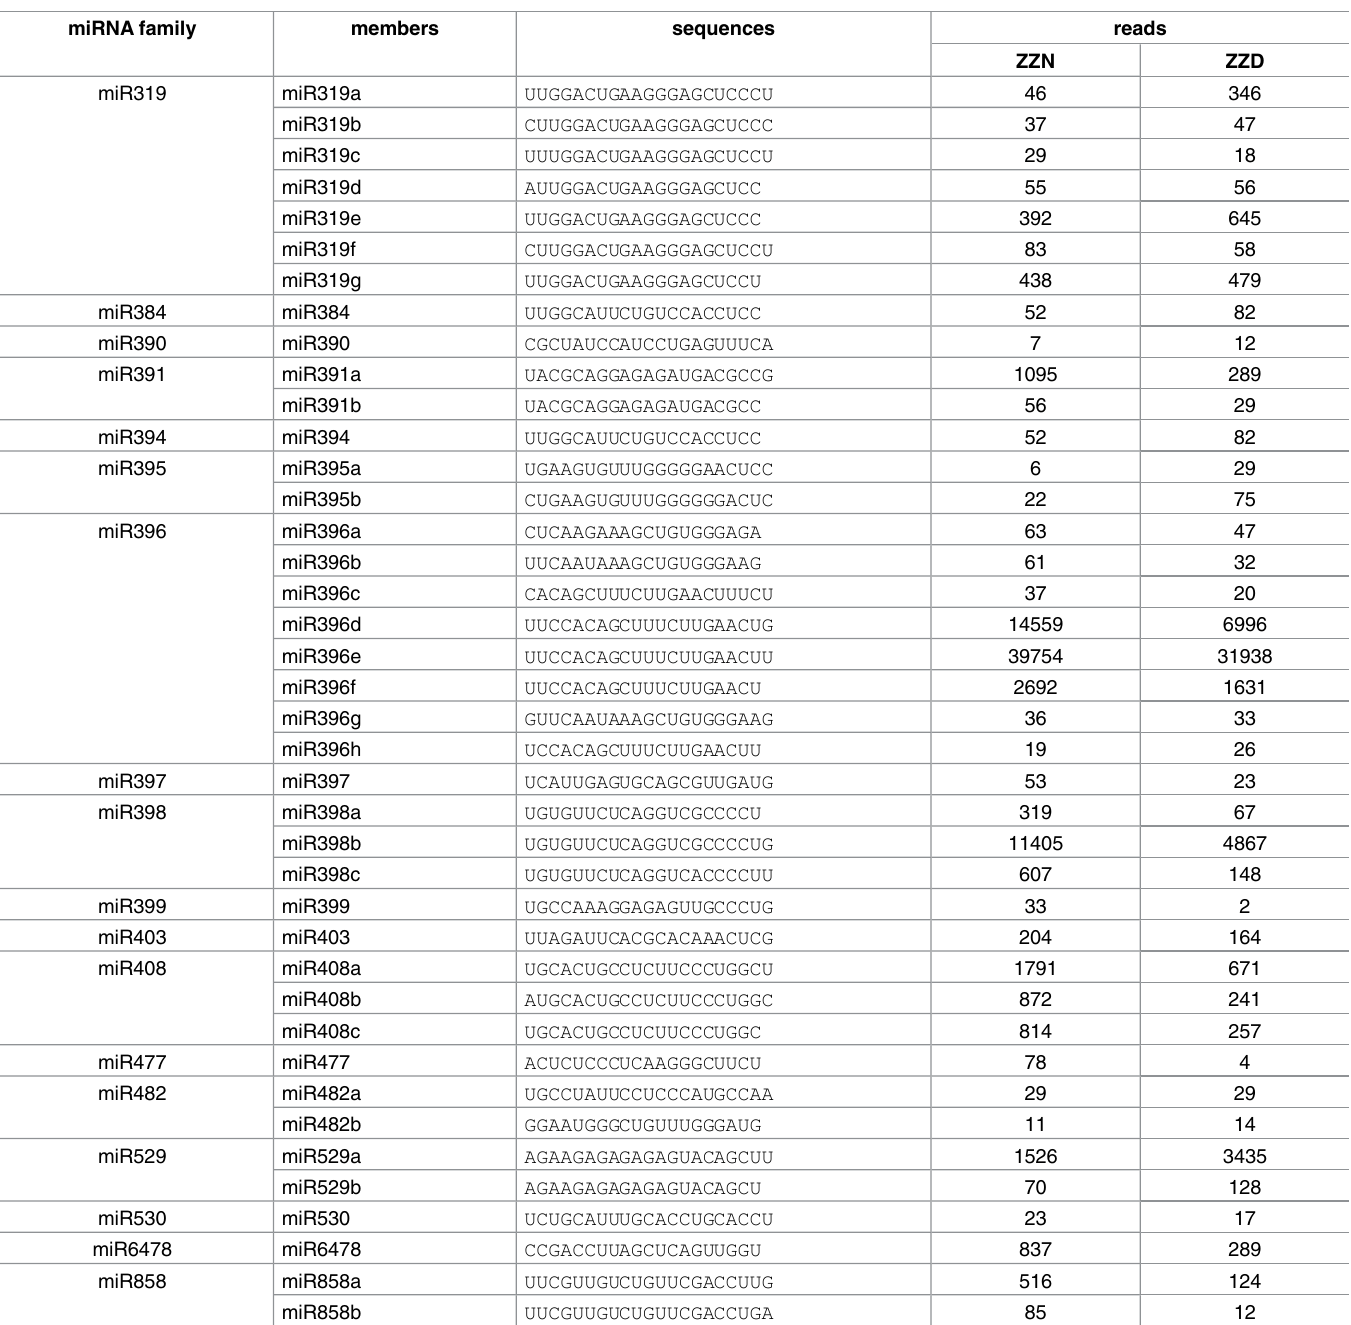
Finally, we have identified 40 targets of 32 conservedmiRNA families with penalty scores of 2.5. The putative functions of the predicted target genes were diverse, most of the target genes were transcription factors, disease resistant genes or the key enzyme genes involved in develop- ment, disease resistance or metabolism. Most targets of conservedmiRNAs in Z . jujuba